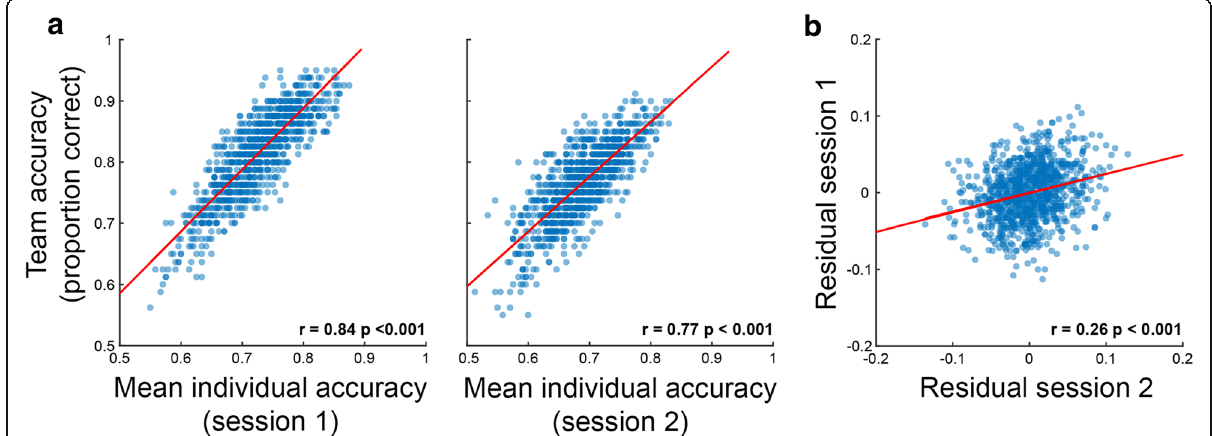
Fig. 6 Regression analysis examining the factors underpinning stability in team accuracy across sessions one and two (Analysis 4). a Scatterplots showing team performance resulting from response aggregation ( y axis) as a function of average accuracy of individual team members ( x axis). Session one data are on the left scatterplot and session two on the right. b Scatterplot of residuals from the expected team accuracy based on linear regression in ( a ) for session one as a function of session two. Details of this analysis are provided in the main